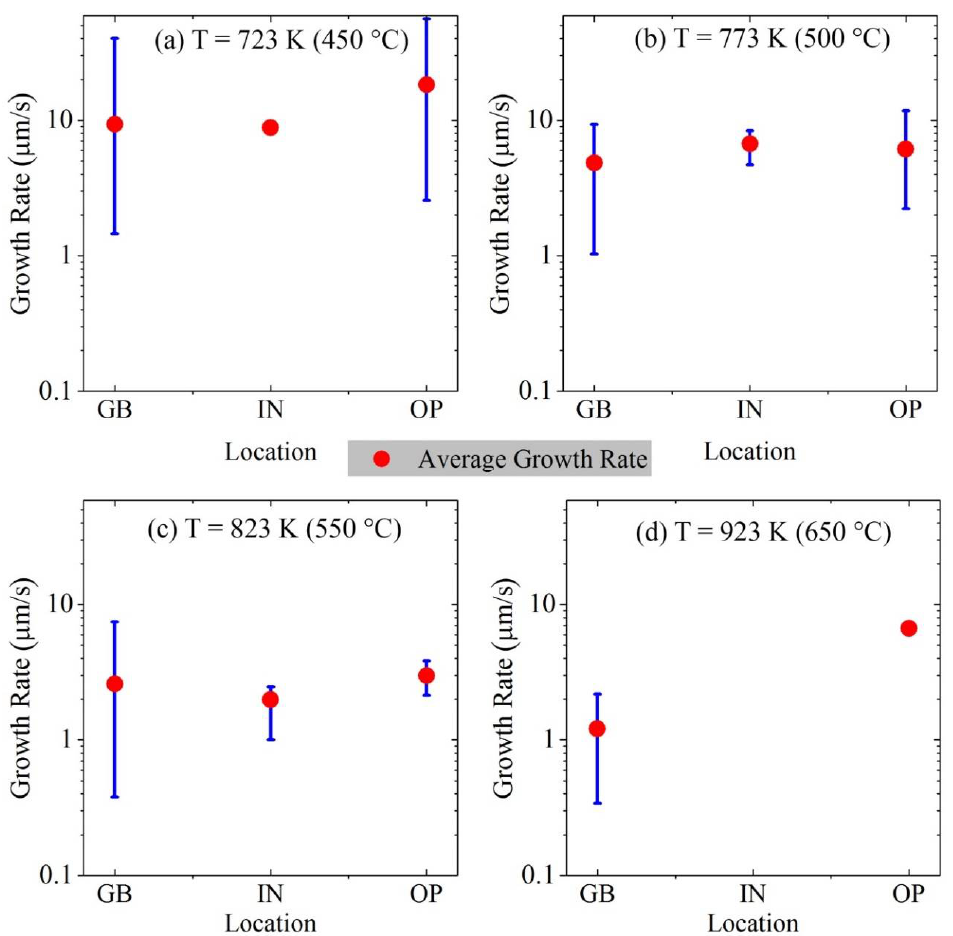
Figure 16. Lengthening rates of bainite plates (in logarithmic scale) observed to nucleate and grow during the cooling step and the isothermal holding step at different locations, namely grain boundary (GB), inside the grain (IN) and on preformed bainite (OP) at ( a ) T = 723 K (450 °C), ( b ) T = 773 K (500 °C), ( c ) T = 823 K (550 °C) and ( d ) T = 923 K (650 °C).